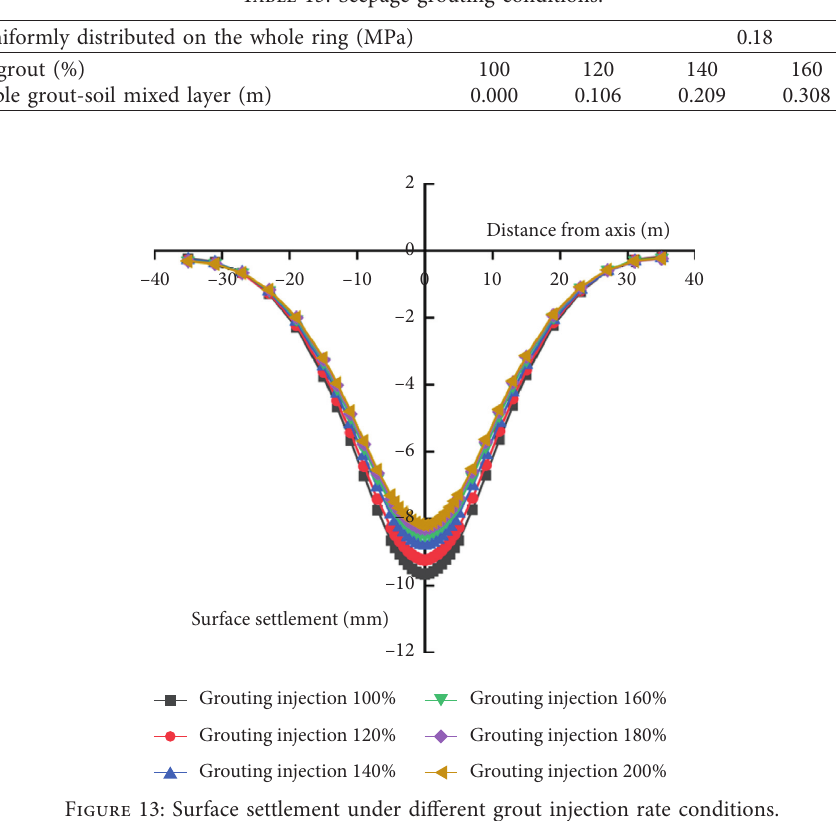
Table 15: Seepage grouting conditions.